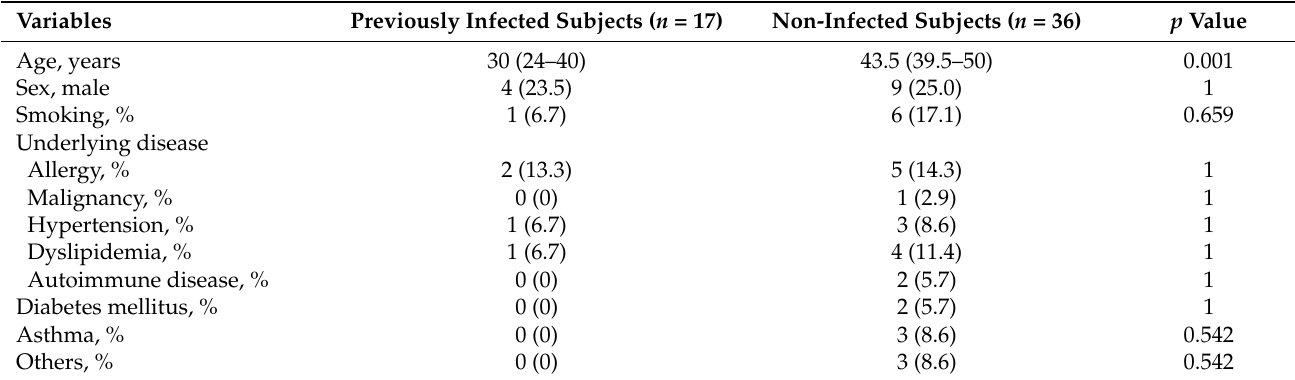
Table 1. Background characteristics of the